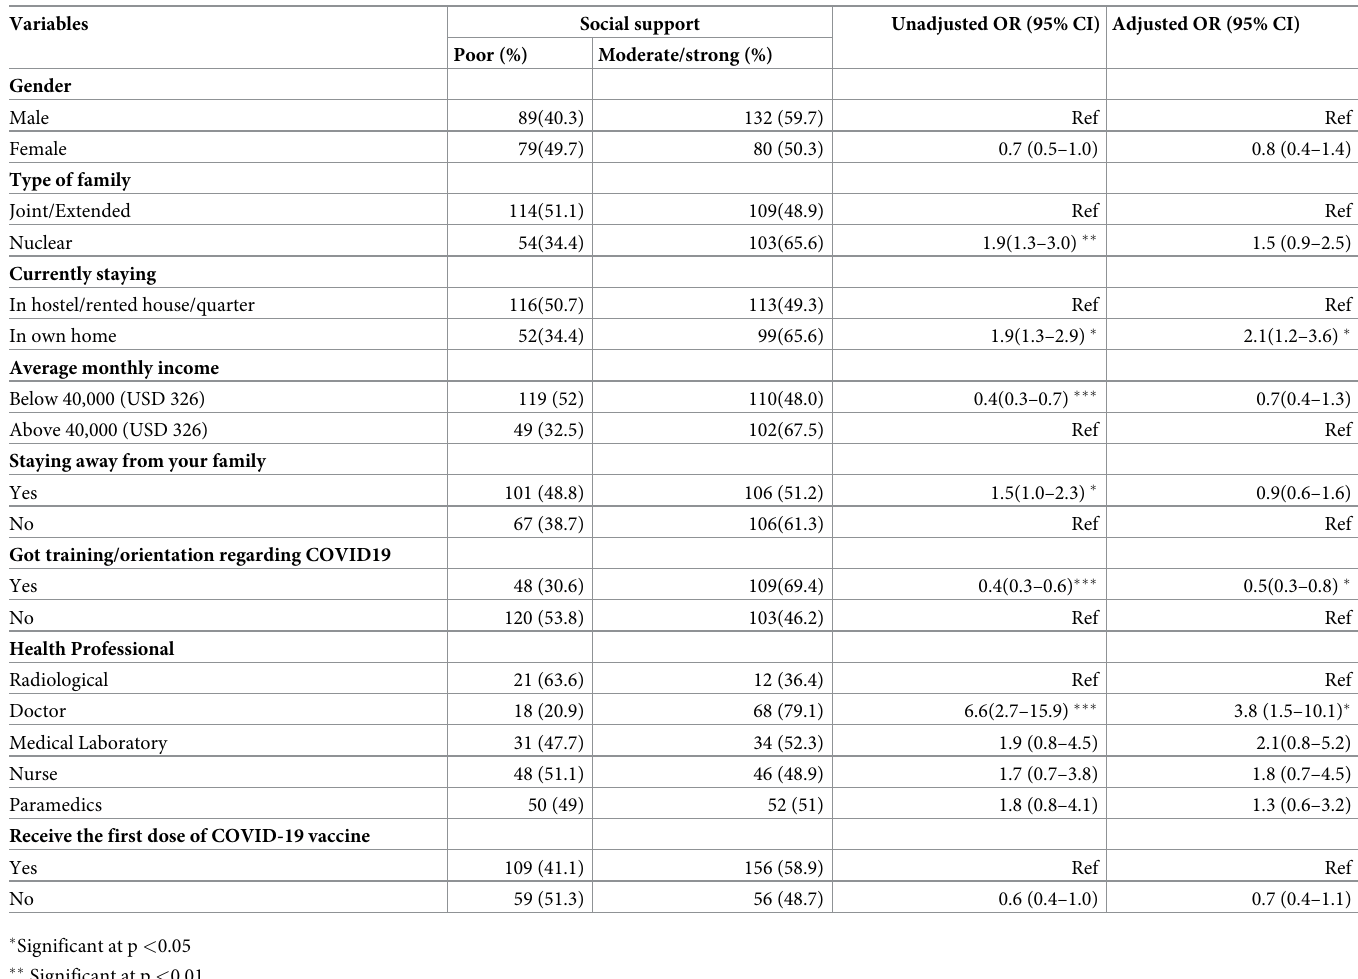
Table 6. Association of social support with independent